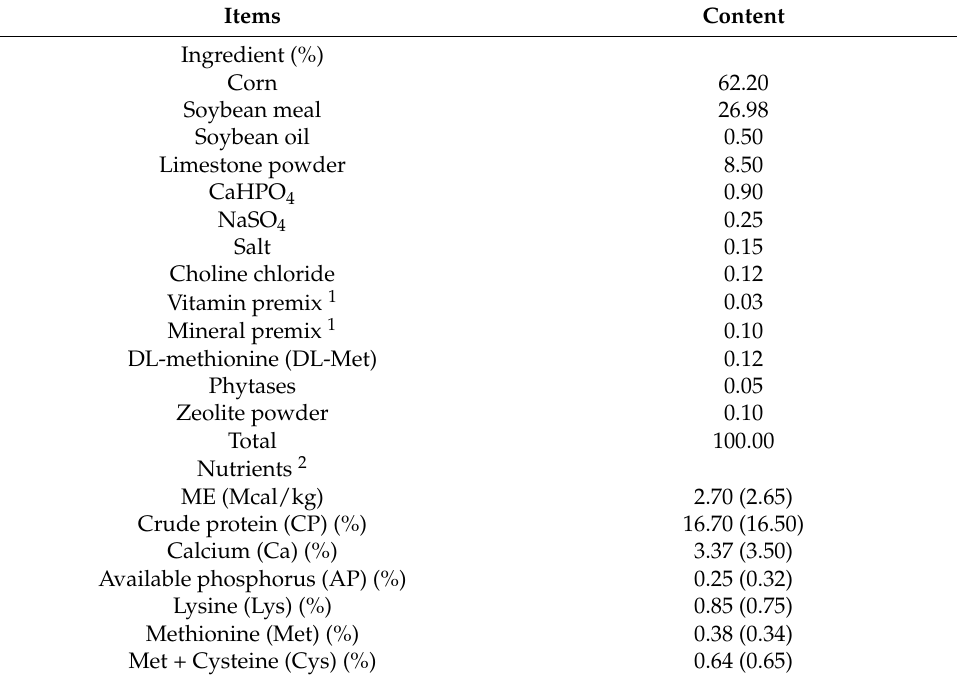
Table 1. Composition and nutrient levels of the basal diet of laying hens (as-feed